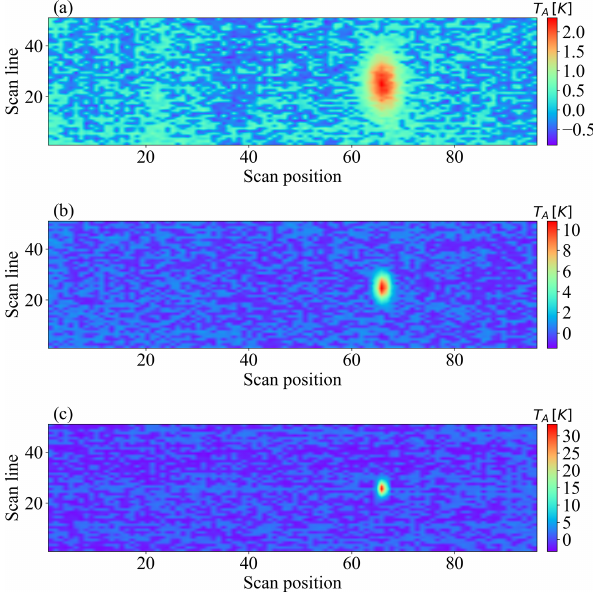
Figure 2. Calibrated lunar antenna temperature T A for channels 1 (a) , 3 (b) , and 17 (c)